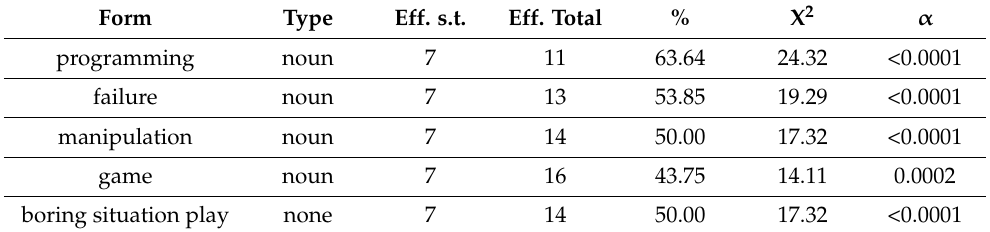
Table 7. More frequent words in class 1: Accessibility and playability.